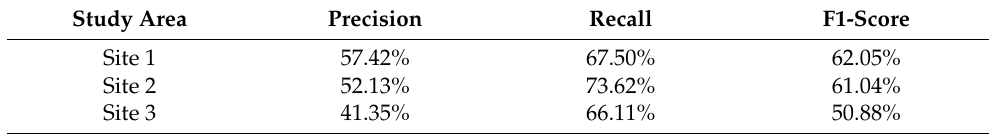
Table 3. Recall, precision, and F1 ‐ score of Mask R ‐ CNN model against different study sites.